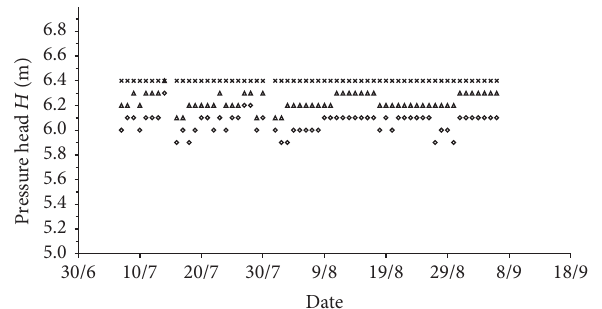
Figure 10: Pressure head values recorded at the inlet 𝑋 = 0 ( × ), the behalf 𝑋 = 𝐿/2 ( 󳵻 ), and at the lateral end tip 𝑋 = 𝐿 (o).